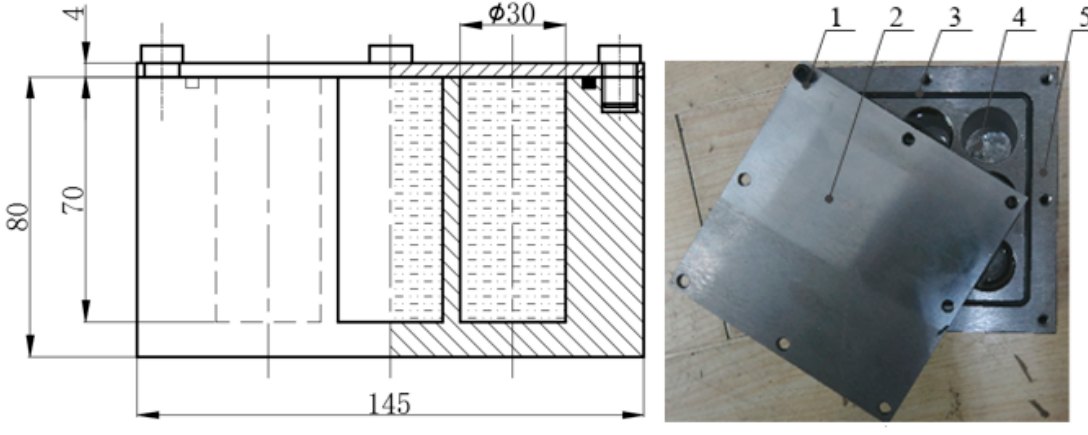
Figure 15. Schematic and physical drawing of the liquid-filled composite structure (LFCS).